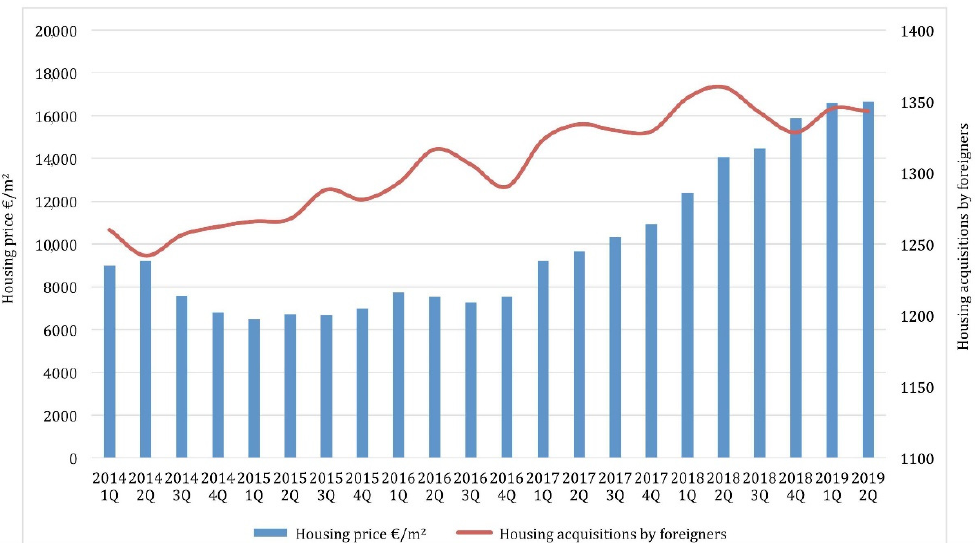
Figure 6. Evolution (by quarters) of the housing prices and of the housing acquisitions by foreigners. Sources: Tinsa, appraisal company approved by the Bank of Spain [46]. Association of Property Registrars. Real Estate Registry Statistics [43]. Author’s elaboration.